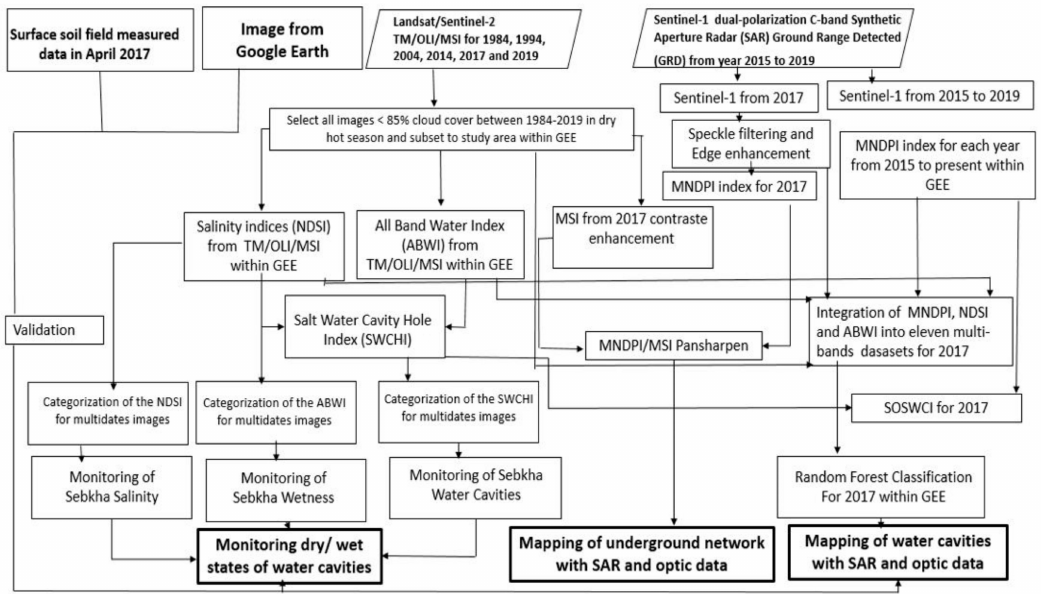
Figure 5. Schematic overview of the methodological